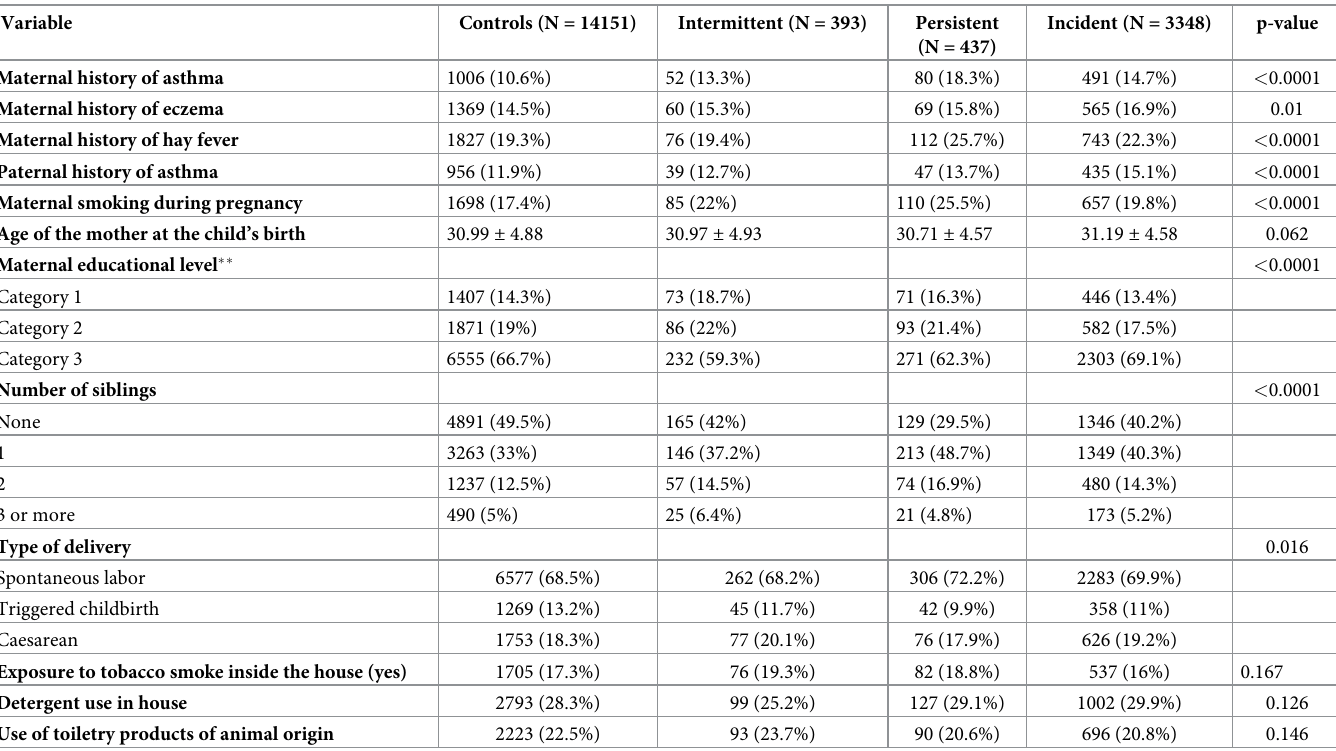
Table 4. Parental risk factors associated with wheezing phenotypes in ELFE